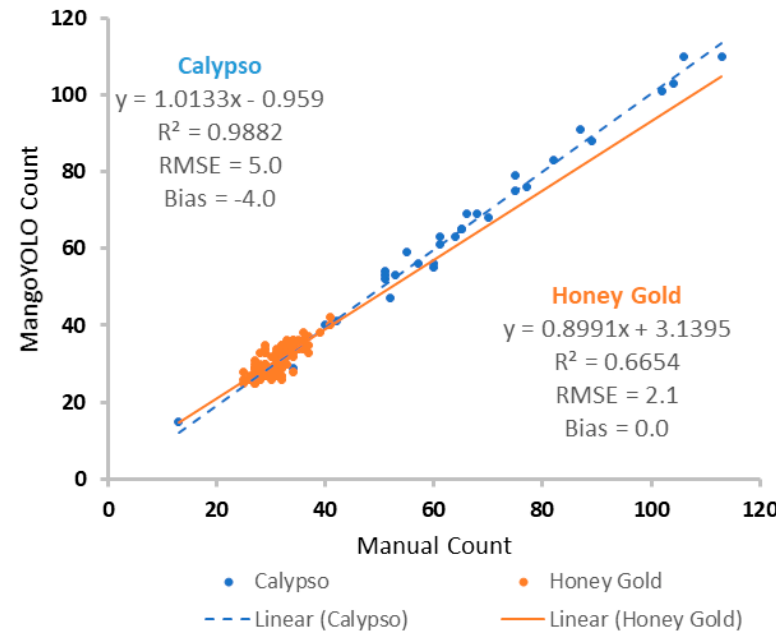
Figure 7. Scatter plot of MangoYOLO count against manual (human) count of fruit per image for images of Calypso tm trees in 2018 (blue symbols), and video of HoneyGold tm trees in 2018 (orange symbols).